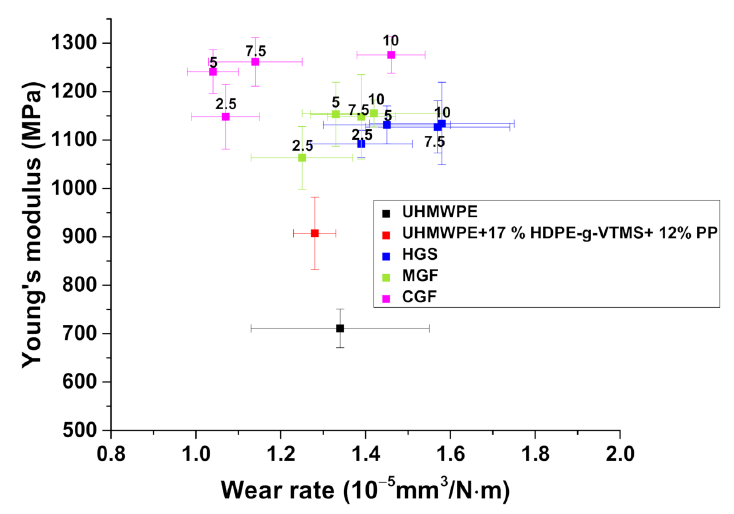
Figure 6. Young’s modulus vs. wear rate (the ‘block-on-ring’ scheme; 60 N · 0.3 m/s);